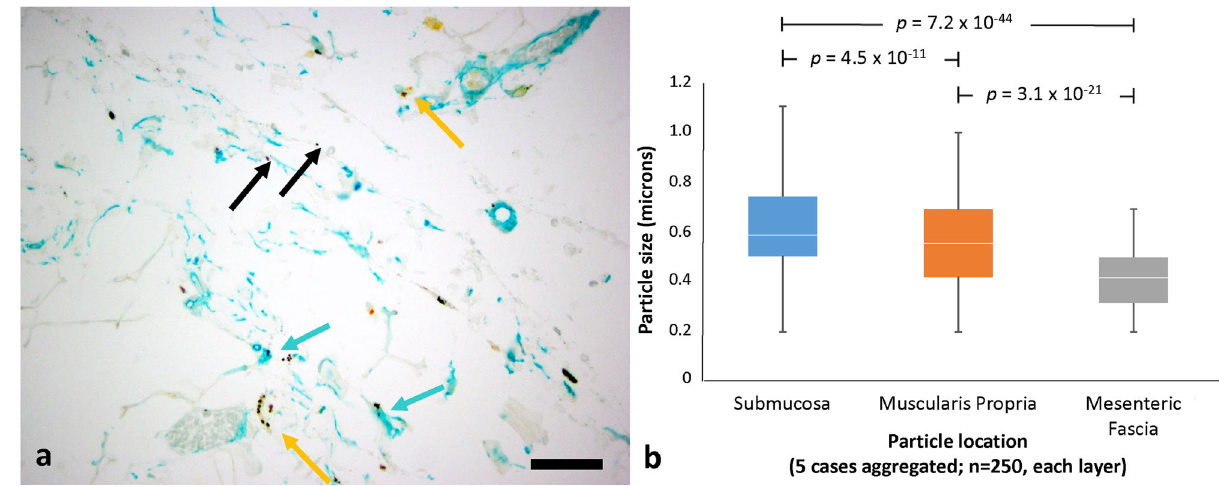
Fig. 3 Tattoo pigment particle distribution in the colon. a Pericolic mesenteric tissues with tattoo pigment within interstitial spaces (black arrows), within macrophages (yellow arrows), and within interstitial lining cells (teal arrows). Selected areas in the colonic submucosa, muscularis propria/super fi cial mesenteric fascia, and deep mesenteric fascia were examined at high power magni fi cation. Double immunostain for CD68 (macrophage marker; yellow) and CD34 (interstitial lining cell marker; teal). Scale bar = 100 μ m. b Distribution of particles by size in compartments at increasing distance from the lumen in aggregated data from all fi ve colon tattoo specimens (50 particles sized for each of the three tissue layers per specimen, with a total of 250 particles represented per layer; each case presented separately in Supplementary Fig. 2). The boxes represent fi rst, median, and third quartiles; the bars represent the range of data